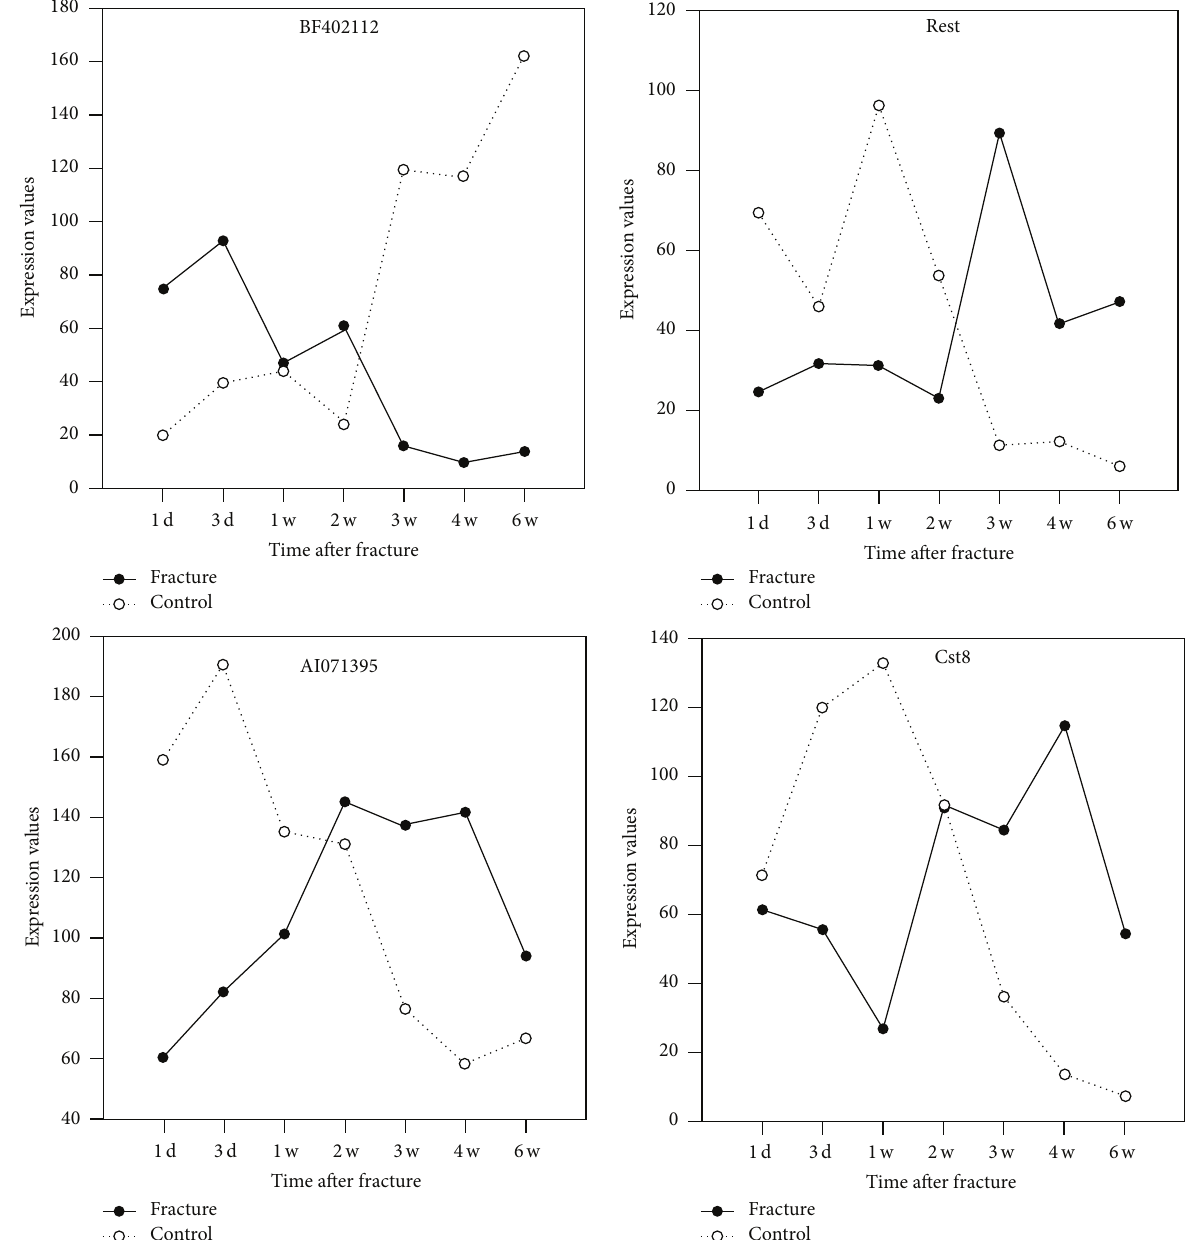
Figure 1: Differentially expressed genes showed contrary regulation tendency in earlier stage and later stage.